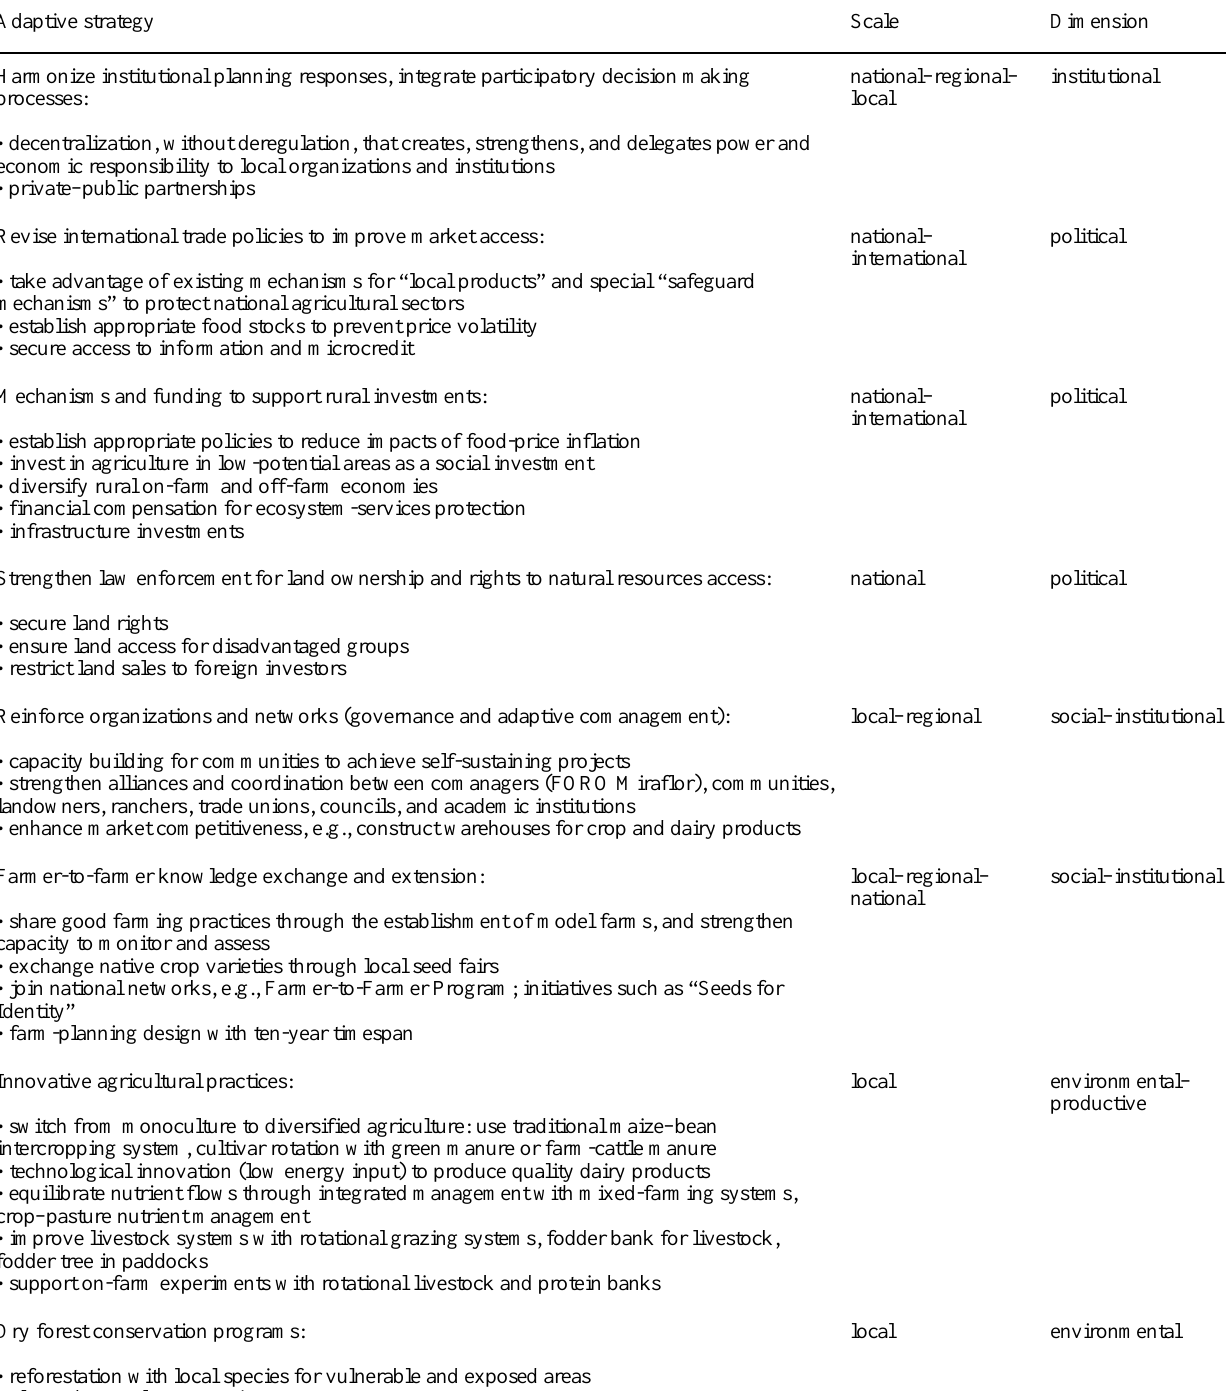
Table 4. Individual and institutional adaptive strategies and policies proposed by stakeholders, their scale, and dimension of